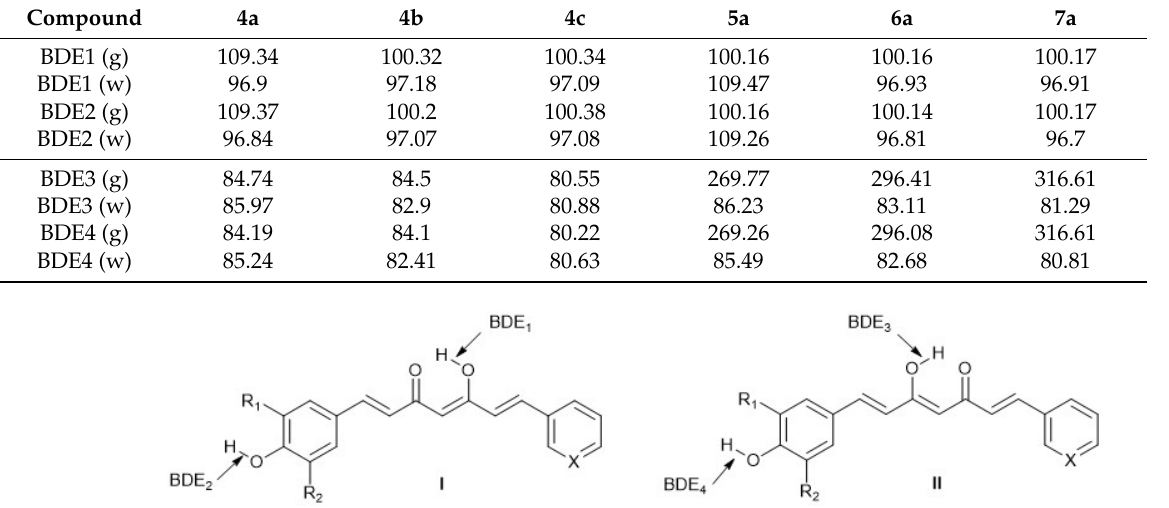
Figure 2. Identification of bond dissociation enthalpies (BDEs) in the possible tautomers (I and II) of the compounds studied.